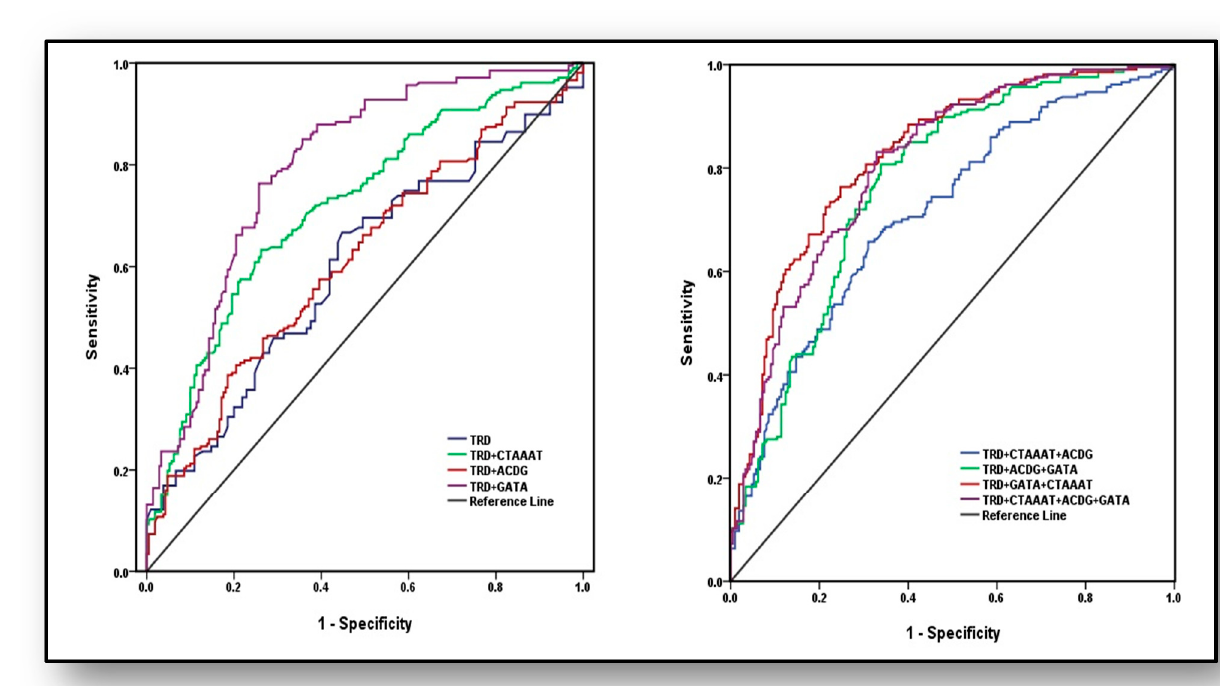
Figure 3. Areas under the receiver operating characteristic (AUROC) curves for the analysis of predictive Scheme 0.028, 95%CI: 0.545–0.654, p < 0.001), TRD + CTAAAT (0.72 ± 0.025, 95%CI: 0.670–0.767, p < 0.001), TRD + ACDG (AUC 0.614 ± 0.027, 95%CI: 0.560–0.668, p < 0.001) and TRD + GATA (AUC 0.80 ± 0.022, 95%CI: 0.751–0.838, p < 0.001). In the second set of model, TRD + CTAAAT + ACDG (AUC 0.71 ± 0.025, 95%CI: 0.665–0.762, p < 0.001), TRD + ACDG + GATA (AUC 0.77 ± 0.023, 95%CI: 0.724–0.814, p < 0.001), TRD + GATA + CTAAAT (AUC 0.824 ± 0.020, 95%CI: 0.784–0.864, p < 0.001) and TRD + CTAAAT + ACDG + GATA (AUC 0.81 ± 0.021, 95%CI: 0.765–0.847, p < 0.001).